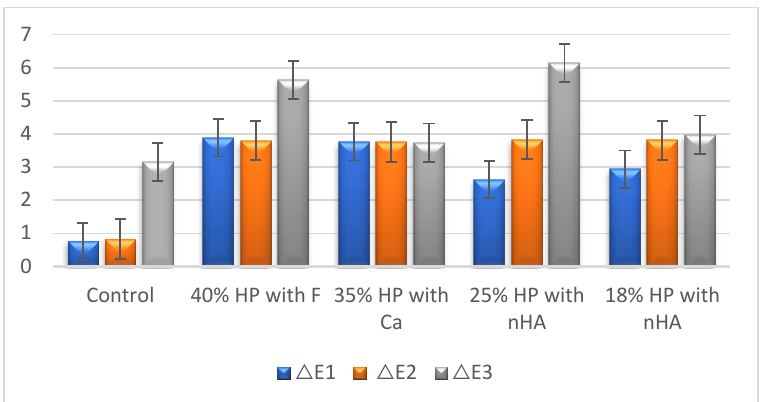
Figure 1. Comparison of the Δ E values of the groups after the bleaching and staining protocols: Δ E1 is after the first session of bleaching; Δ E2 is after the second session of bleaching; Δ E3 is after the staining protocol. HP, hydrogen Peroxide; F, fluoride; Ca, calcium; nHA, nano-hydroxyapatite. The surface roughness values of the groups after evaluation are summarized in Table 3.